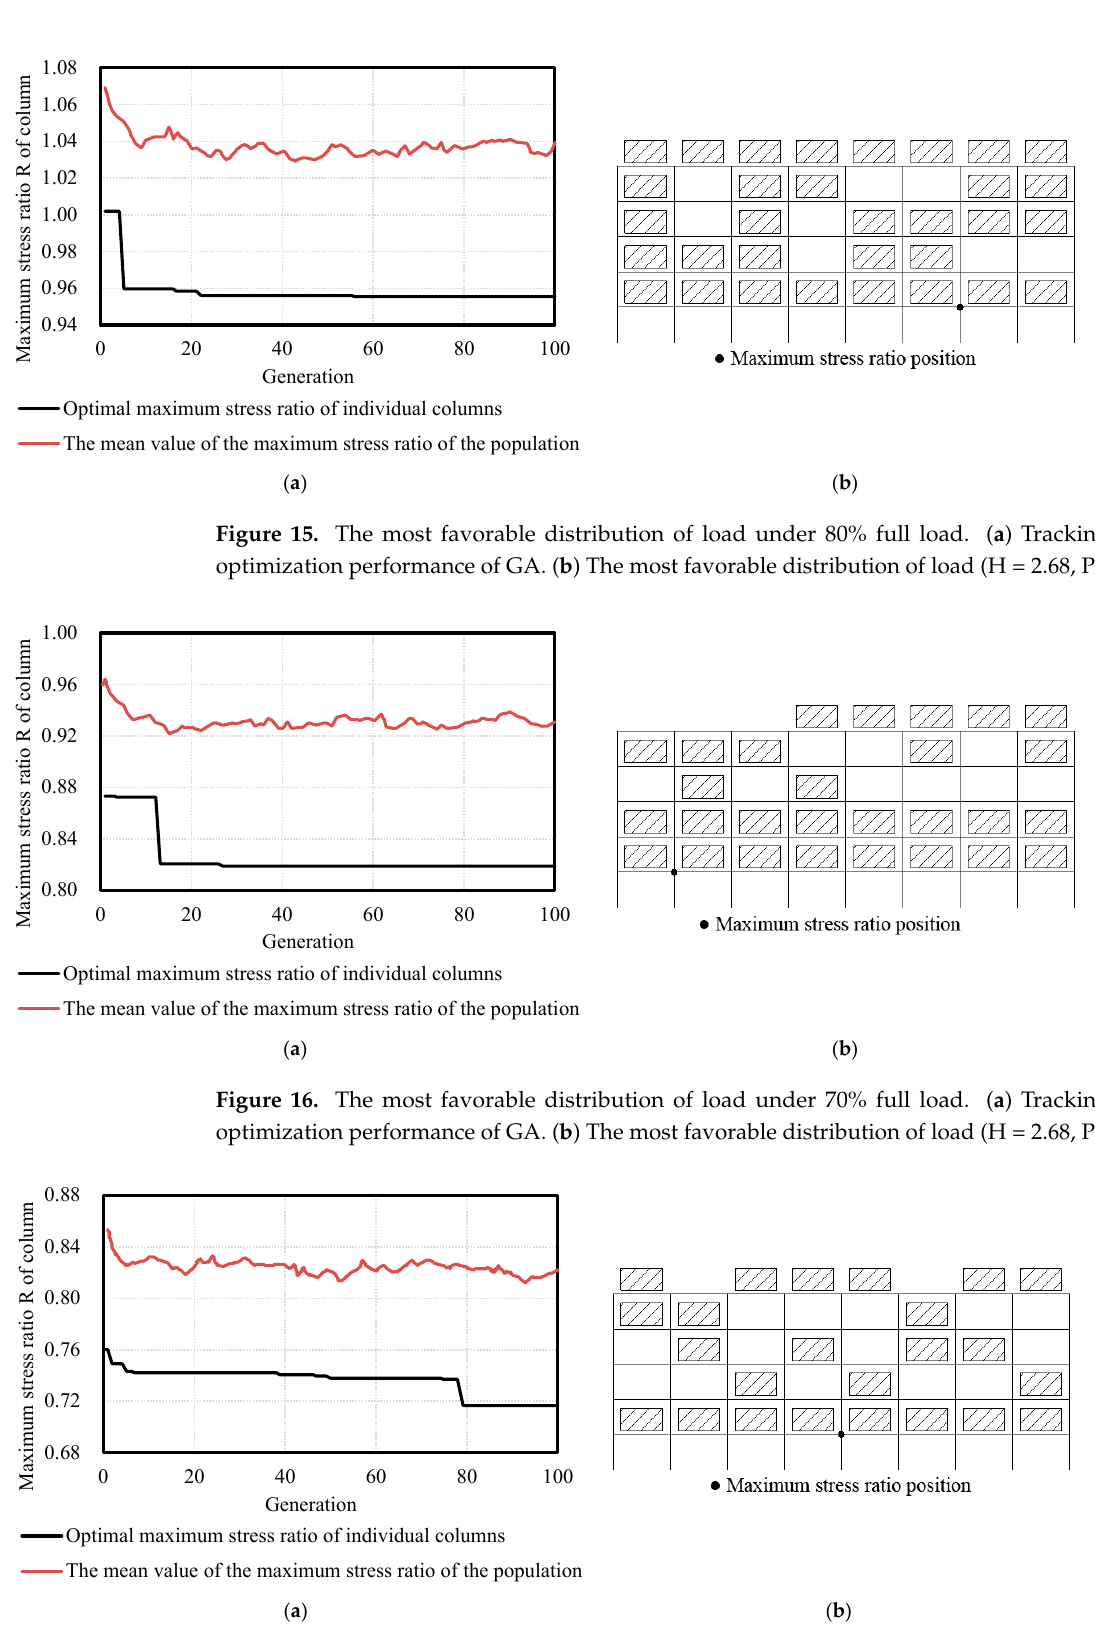
Figure 17. The most favorable distribution of load under 60% full load. ( a ) Tracking chart of optimization performance of GA. ( b ) The most favorable distribution of load (H = 2.83, P = 0.00).